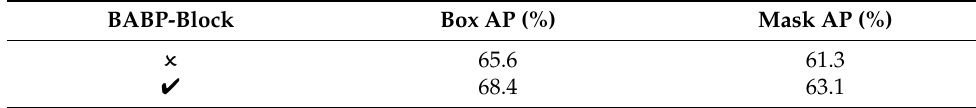
Table 6. Quantitative Results with and Without BABP-Block.